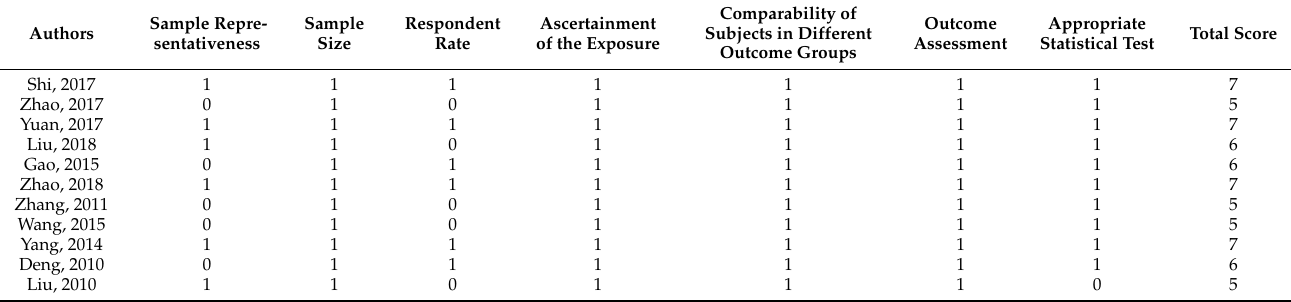
Table 3. Assessment of risk of